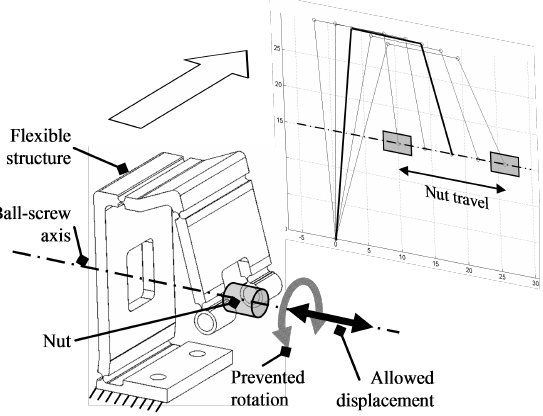
Figure 3. Monolithic frictionless anti-rotation system of the self-sensing linear actuator: prevented rotation and allowed displacement of the nut.